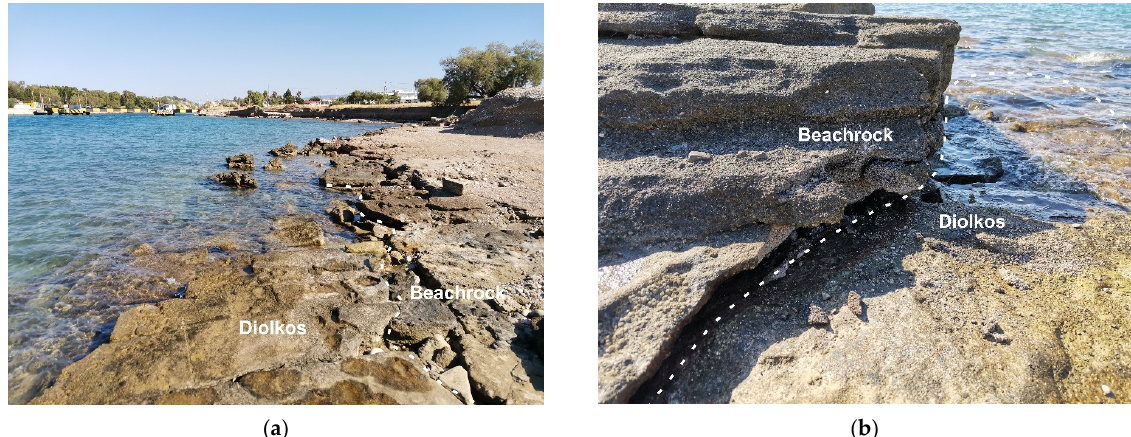
Figure 6. Southern Diolkos part. ( a ) Inland view. The dashed white line separates the beachrock B from Diolkos remnants. The erosion of Diolkos coastal zone can be observed. ( b ) Contact point of beachrock B with Diolkos remnants. From this site, the sample DiS1 was retrieved.